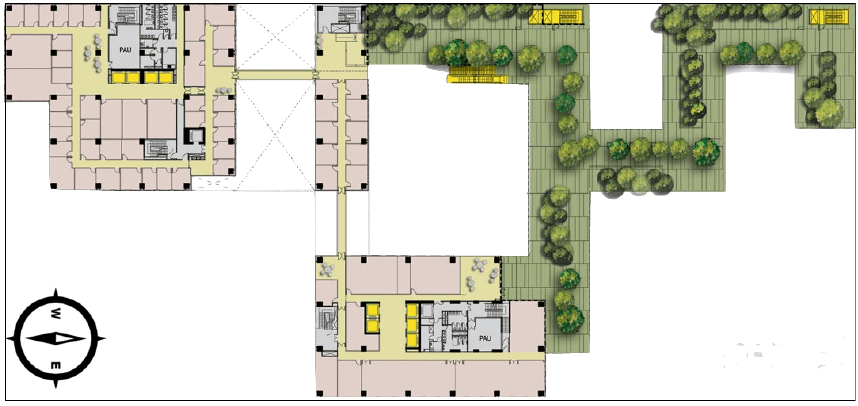
Figure 24. The plan of test